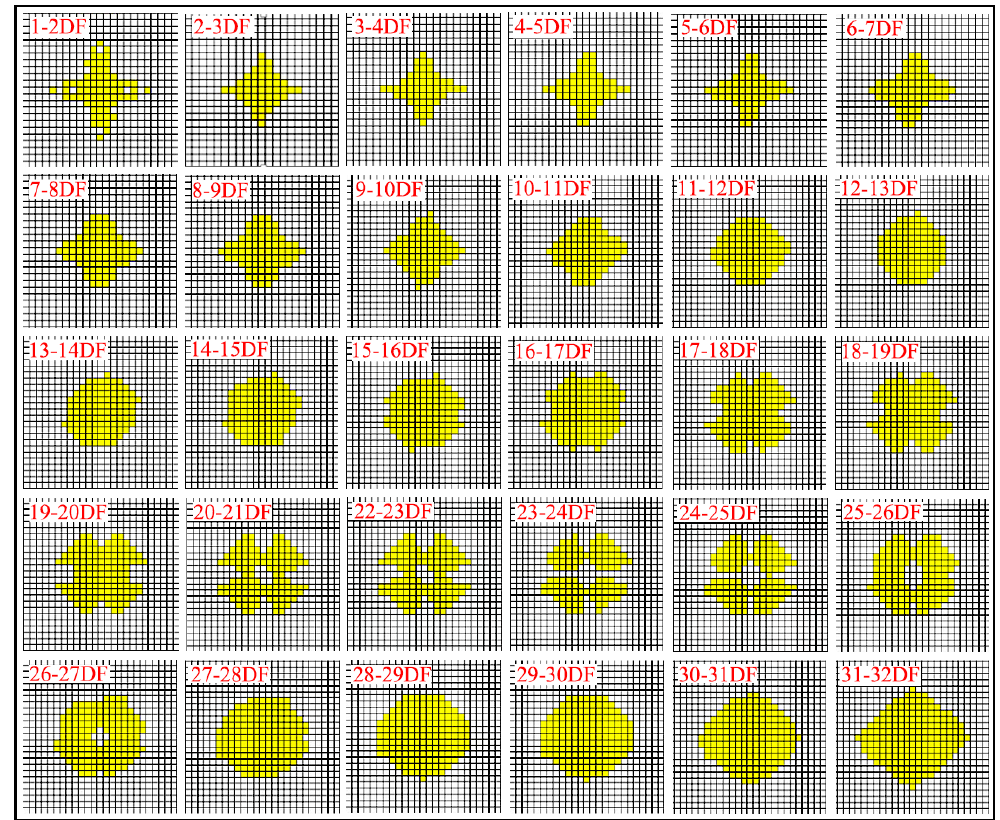
Figure 7. Final failure of each interface after the impact of 16.8 J.